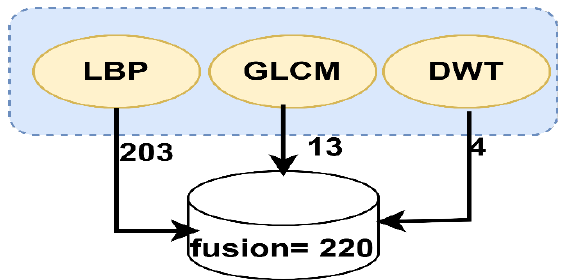
Figure 7. The hybrid LBP, GLCM, and DWT algorithms used to extract features from the analyzed images.